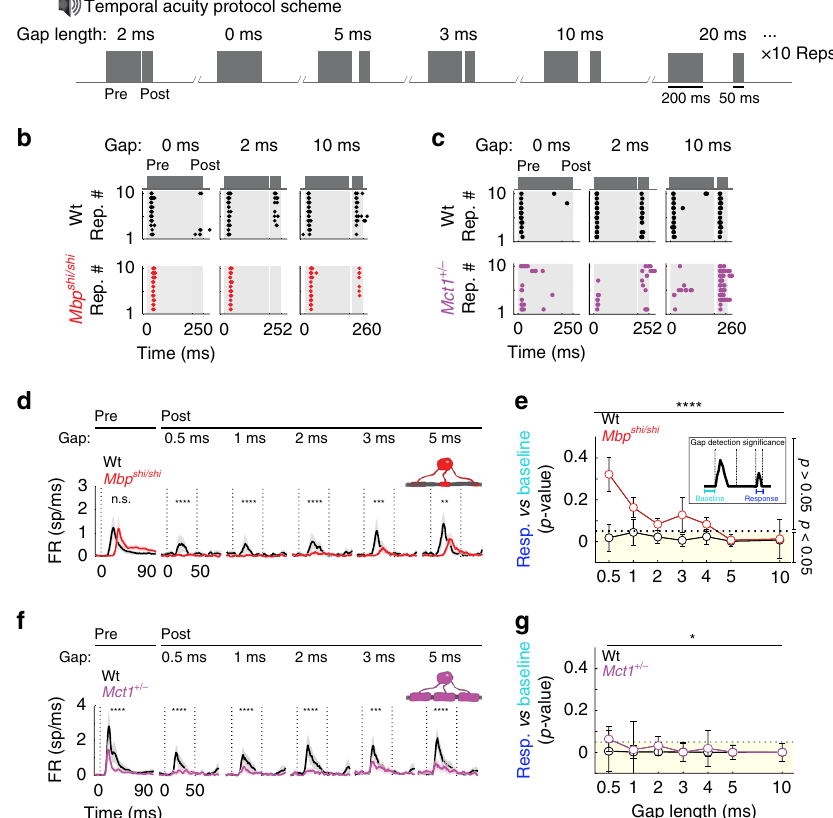
Fig. 3 Cortical temporal acuity is severely impaired with central nervous system (CNS) dysmyelination and partially impaired upon axoglial metabolic reduction. a Temporal acuity test: gap-detection protocol. A pregap broadband noise (BBN, 200 ms) followed by a silent gap (0 – 50 ms, ten repetitions each) and post-gap BBN (50 ms). b Example for Wt (upper, black) and Mbp shi/shi (lower, red): sound-evoked (gray patch) ACx spikes (dots) before/after gaps of 0-ms (left), 2-ms (center), and 10-ms (right) length, across ten repetitions. c Same as in b for the Mct1 (purple). d Average peristimulus time histogram (PSTH) for Wt (black, n = 12) and Mbp shi/shi (red, n = 14). Left to right: pregap responses followed by post-gap responses for 0.5 – 5-ms gaps. Effect of group for post-gap, but not pregap, responses (two-way ANOVAs [ F (1,462) = 0.53, P = 0.46], [ F (1,502) = 24.47, P = 1.03 × 10 − 6 ], [ F (1,502) = 20.48, P = 7.54 × 10 − 6 ], [ F (1,502) = 24.06, P = 1.26 × 10 − 6 ], [ F (1,502) = 14.38, P = 0.0002], and [ F (1,502) = 7.62, P = 0.006]. e Quanti fi cation of signi fi cance (median p value between baseline and post-gap response/recording, see inset). Lower detection in Mbp shi/shi (red, n = 20 sites, 14 animals) than Wt (black, n = 15 sites, 12 animals) for short gaps, group effect (two-sided Kruskal – Wallis, F (1,214) = 15.81, P = 7 × 10 − 5 ). Dotted line: threshold at 0.05. Yellow shadow: signi fi cant gap detection. f Same as d for Mct1 + / − (purple, n = 6) and Wt (black, n = 8). Group effect for all responses (two-way ANOVAs [ F (1,252) = 30.06, P < 0.0001], [ F (1, 313) = 24.42, P = 1.26 × 10 − 6 ], [ F (1,313) = 15.74, P = 9.02 × 10 − 5 ], [ F (1,313) = 36.65, P = 4.03 × 10 − 9 ], [ F (1,313) = 10.53, P = 0.001], and [ F (1,313) = 21.3, P = 5.73 × 10 − 6 ]. g Same as e for Mct1 + / − mice (purple, n = 9 sites, six animals) and Wt mice (black, n = 13 sites, eight animals). Group effect (two-sided Kruskal – Wallis, F (1,151) = 8.83, P = 0.0027). d , f Dotted lines: sound onset and offset. e , g Circles: median/group/gap length, and error bars: S.E.M. Source data are provided as a Source Data fi